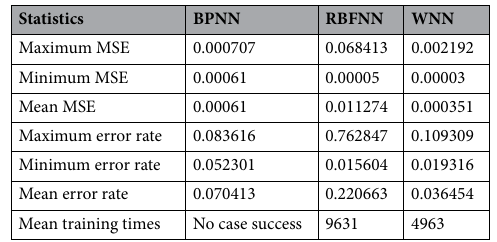
Table 8. Comparative results of BPNN, RBFNN and WNN on generation dataset.